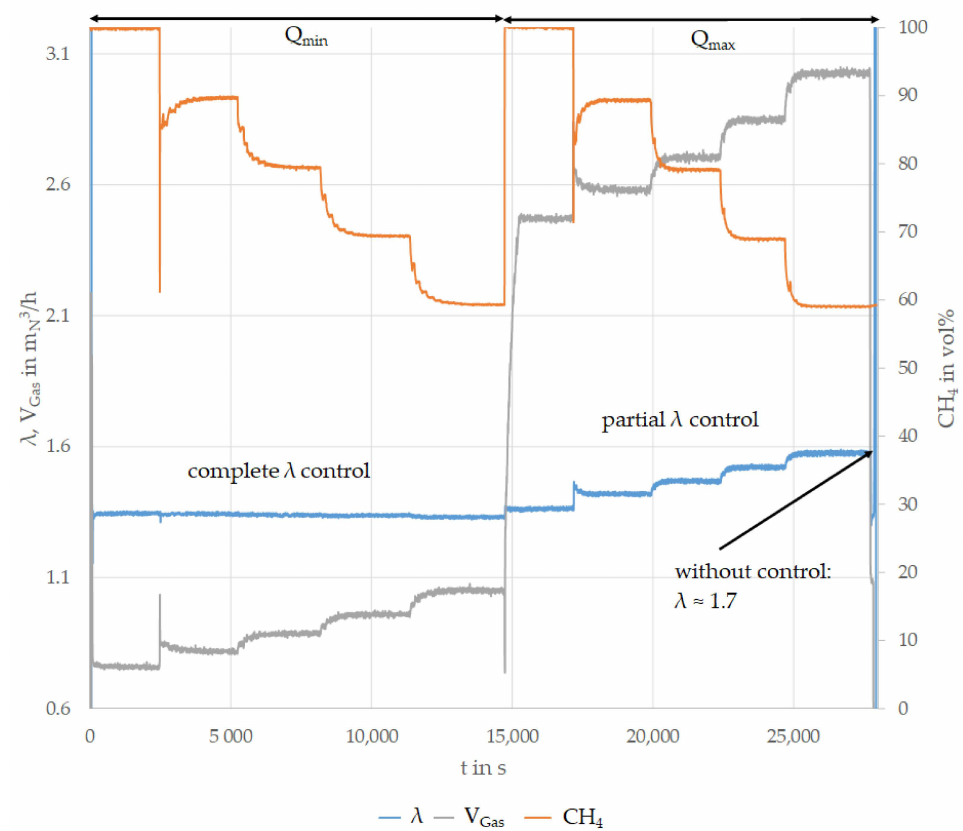
Figure 7. Response of a combustion-controlled appliance to various levels of hydrogen in methane at minimum and full load. minimum and full